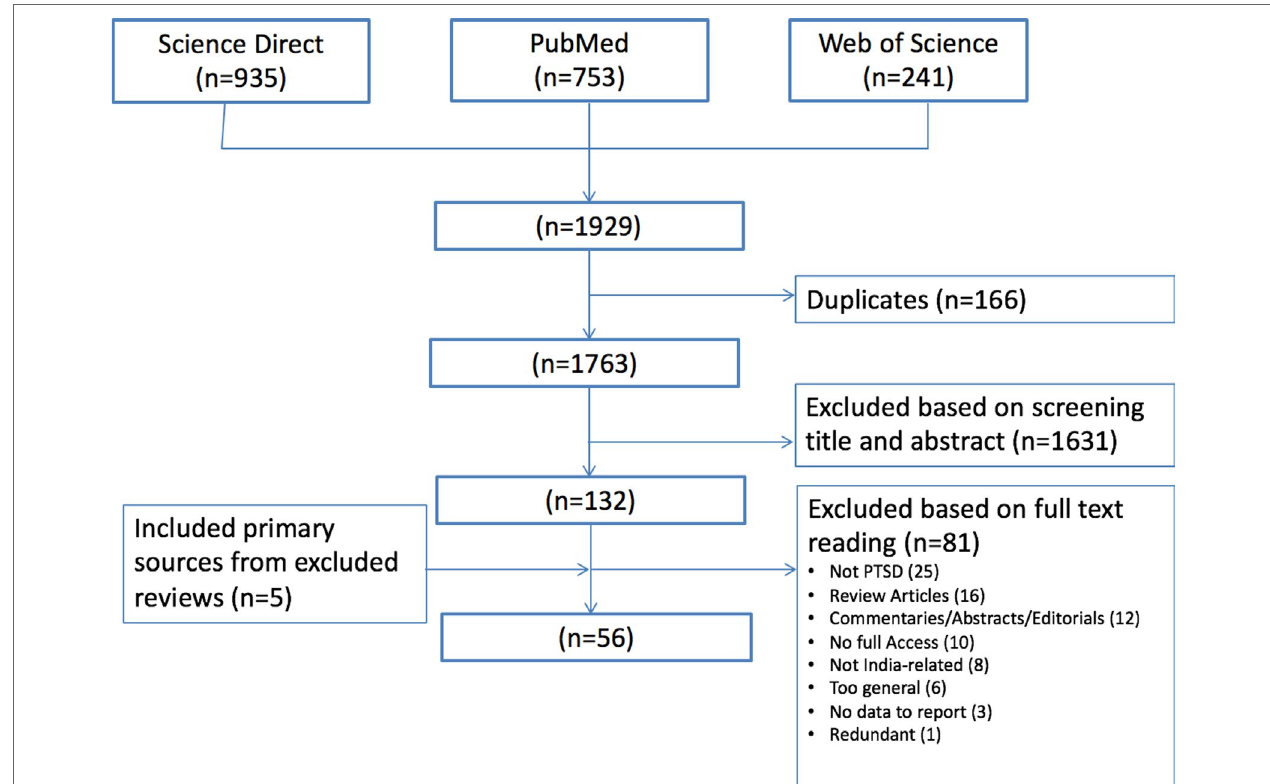
FIGURE 1 | Flow chart overview of article selection